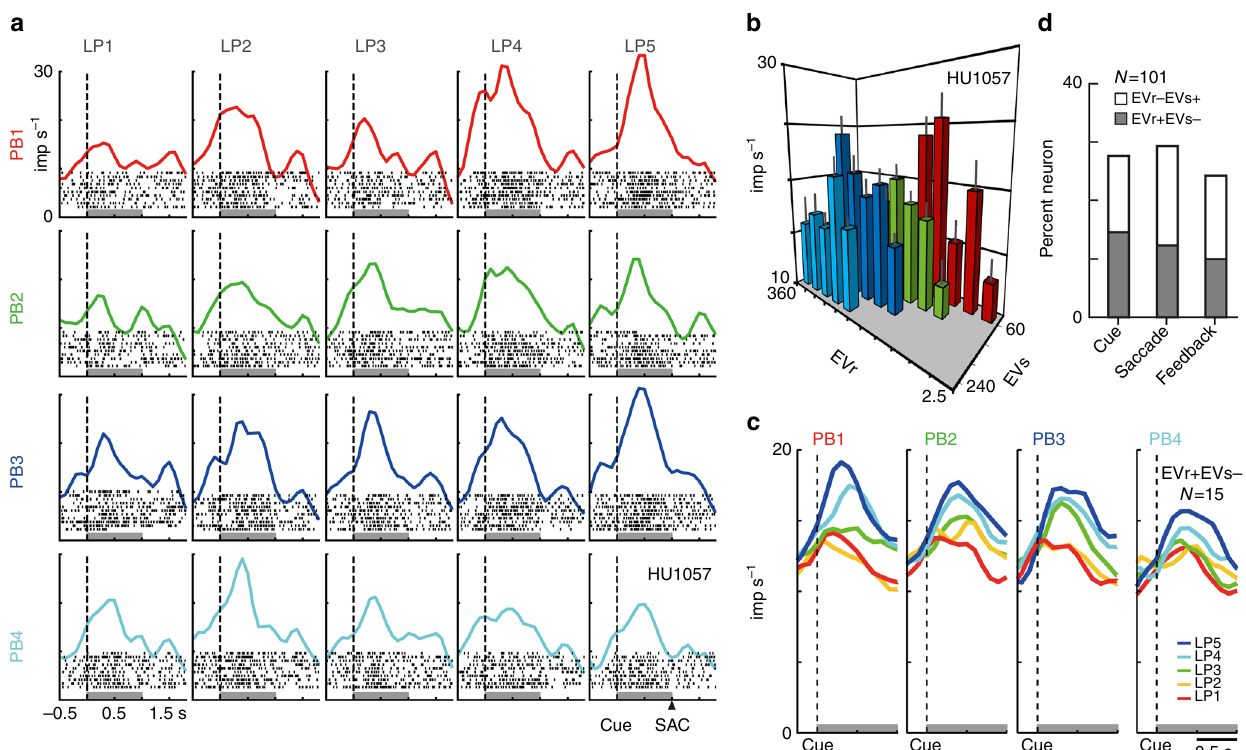
Fig. 2 Relative value signals in the activity of mOFC neurons. a Rasters and histograms of an example mOFC neuron modulated by the relative value of options. The activity aligned at cue onset during free choice trials was shown for 20 lottery pairs (four PBs times fi ve LPs, 200 trials). Black dots in the histograms indicate raster of spikes. Gray bars indicate the cue period to estimate the neuronal fi ring rates shown in b . SAC indicate approximate time of saccade onset. b Activity plot of the mOFC neuron in a against the expected values of risky (EVr) and safe option (EVs). Error bars indicate s.e.m. The neuron showed positive and negative regression coef fi cients for EVr and EVs (EVr+EVs − type, EVr, 0.042, EVs, − 0.048, AIC = 1283), respectively. c Activity histogram of 15 mOFC neurons modulated by relative values of risk and safe options during cue period (EVr+EVs – type). Activity in each of four payoff blocks (PB1 – 4) is shown for the fi ve types of lottery pairs (LP1 – 5). d Percentage of mOFC neurons modulated by relative values during three task periods. Gray indicates activity showing the positive and negative regression coef fi cients for EVr and EVs, respectively (EVr+EVs − type). White indicates activity showing negative and positive regression coef fi cients for EVr and EVs, respectively (EVr − EVs+